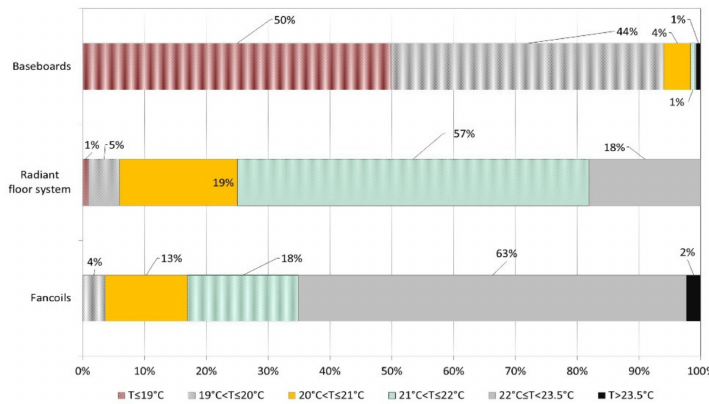
Figure 16. Percentage of time in comfort range for all systems—air